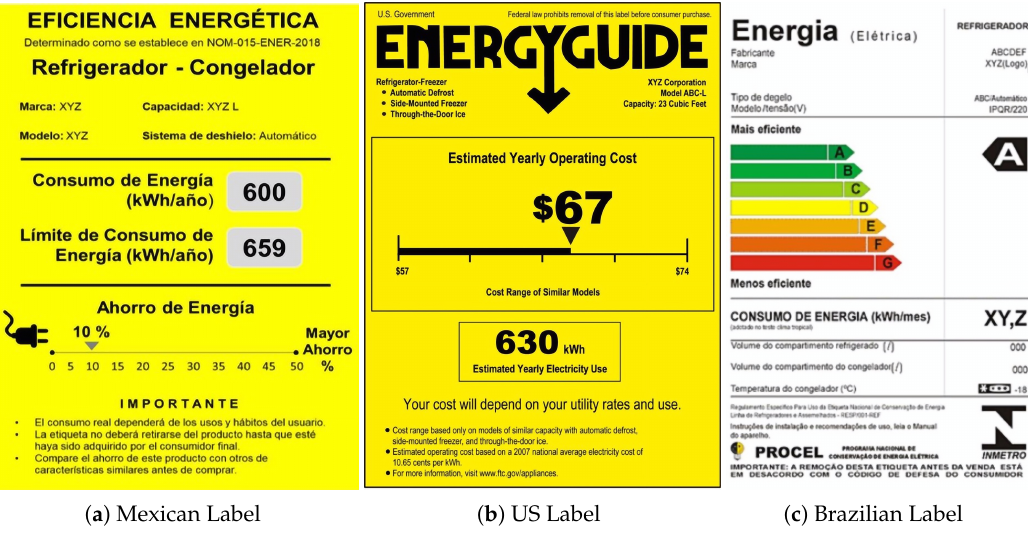
Figure 5. Energy labels for domestic refrigeration in Mexico, US and